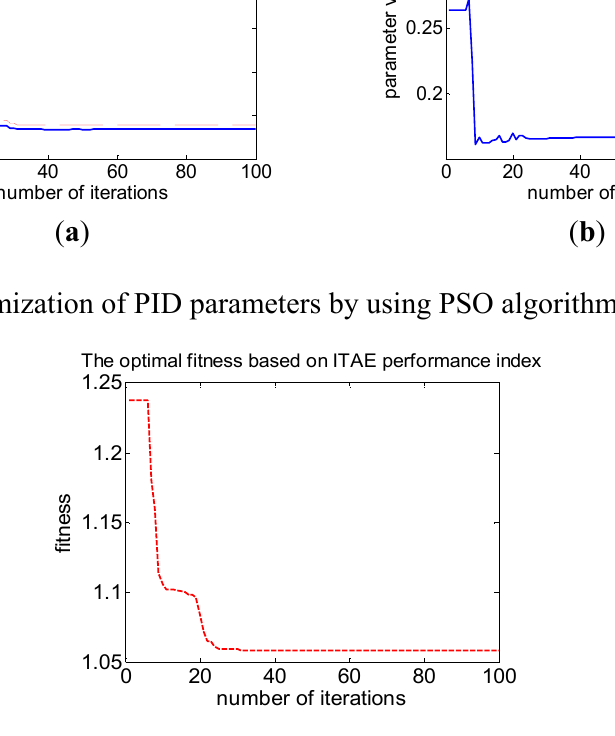
Figure 14. A variation of the integrated time and absolute error (ITAE) performance